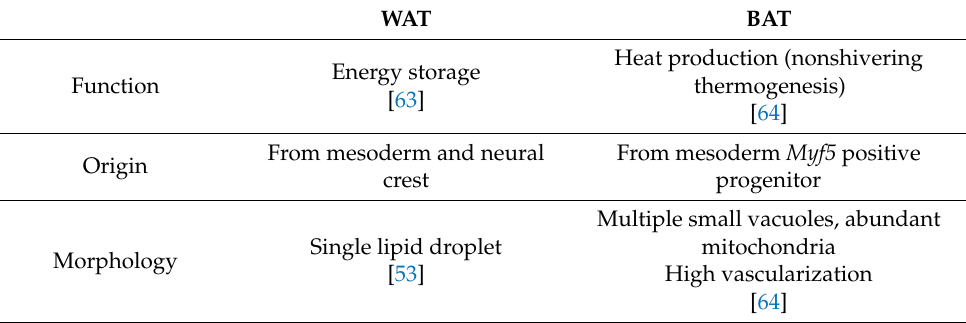
Table 1. Adipose tissue biology. Overview of the comparative characteristics of white (WAT) and brown (BAT) adipose tissue and their respective roles. Myf5, myogenic factor 5; UCP1, uncoupling protein